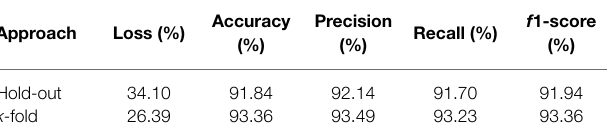
TABLE 3 | Model prediction quality evaluation metrics for hold-out and k -fold approaches in classifying soybean genotypes in 11 populations from different relative maturity